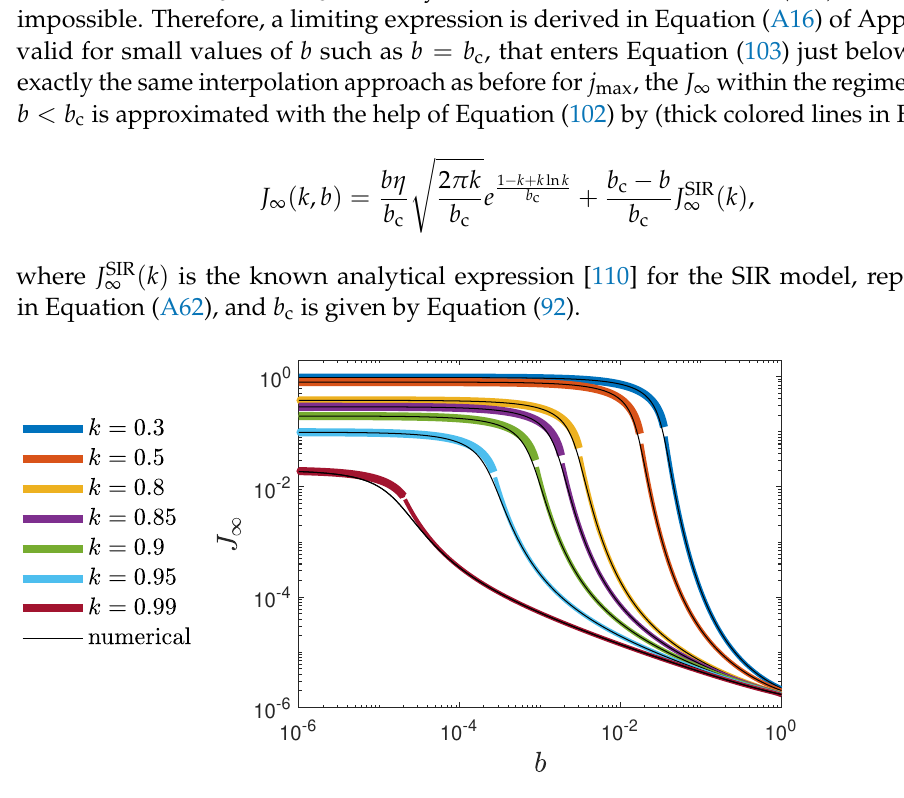
Figure 7. Final (infinite time) fraction of infected persons, J ∞ , versus reduced vaccination rate, b , for various k at η = 10 − 6 (double-logarithmic plot). The exact numerical solution (solid black) is compared with the approximant (102) within the regime of b > b c (thin colored), and by the interpolant (103) (thick colored) for the remaining regime of very small b < b c . The limiting value J ∞ ( b → 0 ) exactly coincides with the J SIR ∞ ( k ) of the SIR model (see Appendix